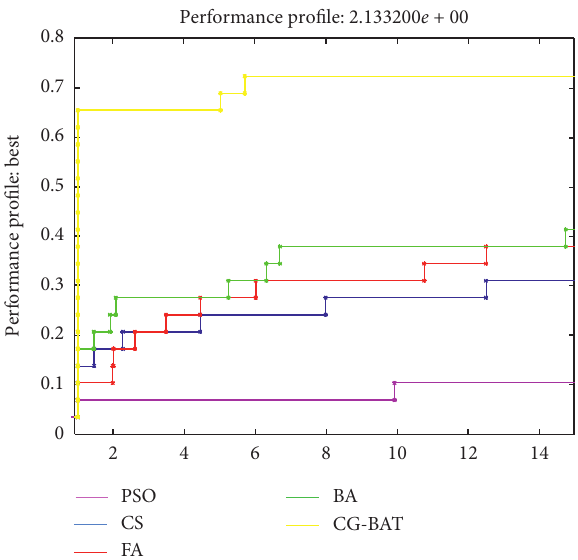
Figure 7: Performance profiles based on best